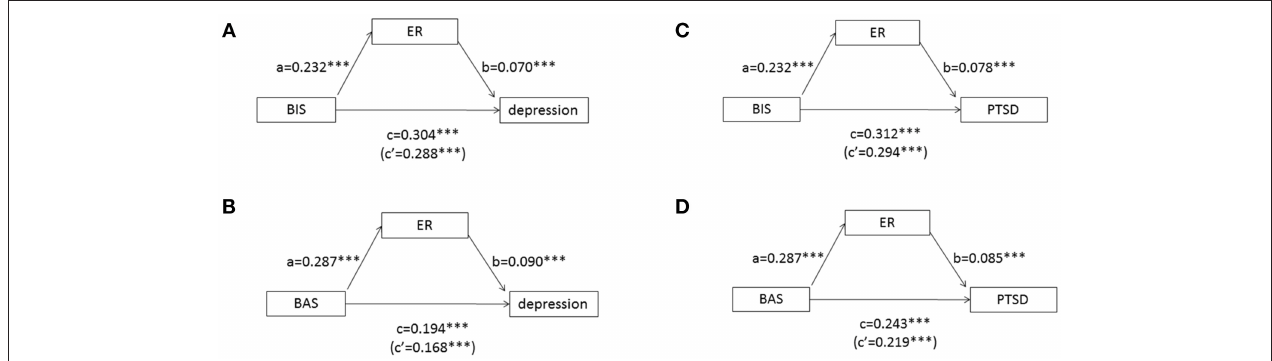
FIGURE 2 | Hypothesized meditation models between motivation, emotion regulation, and mood symptoms. (A) Emotion regulation (ER) partially mediates the relationship between BIS sensitivity (as measured by the BBS) and depression (as measured by the SCL-90). (B) ER partially mediates the relationship between BAS sensitivity (as measured by the BBS) and depression. (C) ER partially mediates the relationship between BIS sensitivity and PTSD (as measured by the PCL-M). (D) ER partially mediates the relationship between BAS sensitivity and PTSD. Path values represent standardized regression coefficients (unstandardized coefficients are presented in the text). Bootstrapping and causal path analyses suggest mediation in both models. *** P <